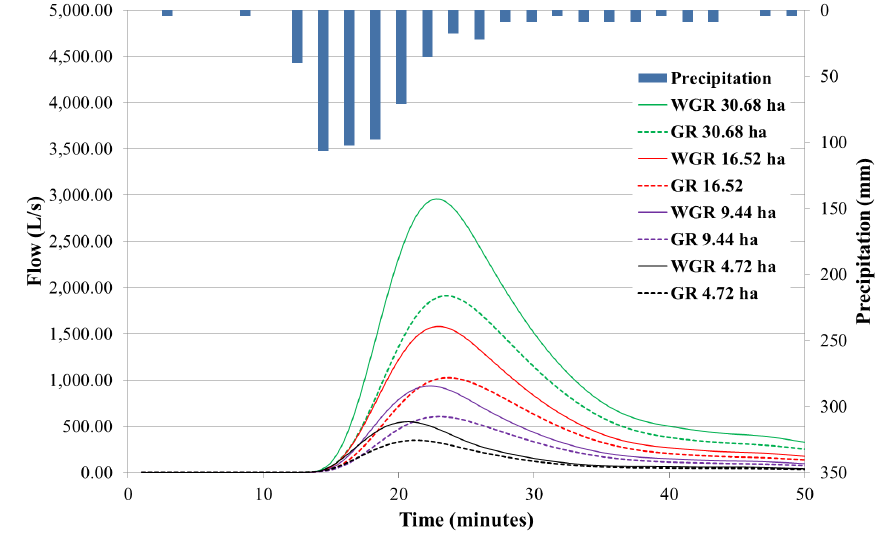
Figure 3. Hydrographs in drainage areas with 4.72, 9.44, 16.52 and 30.68ha for rainfall event 2 (WGR: without green roof; GR: with green